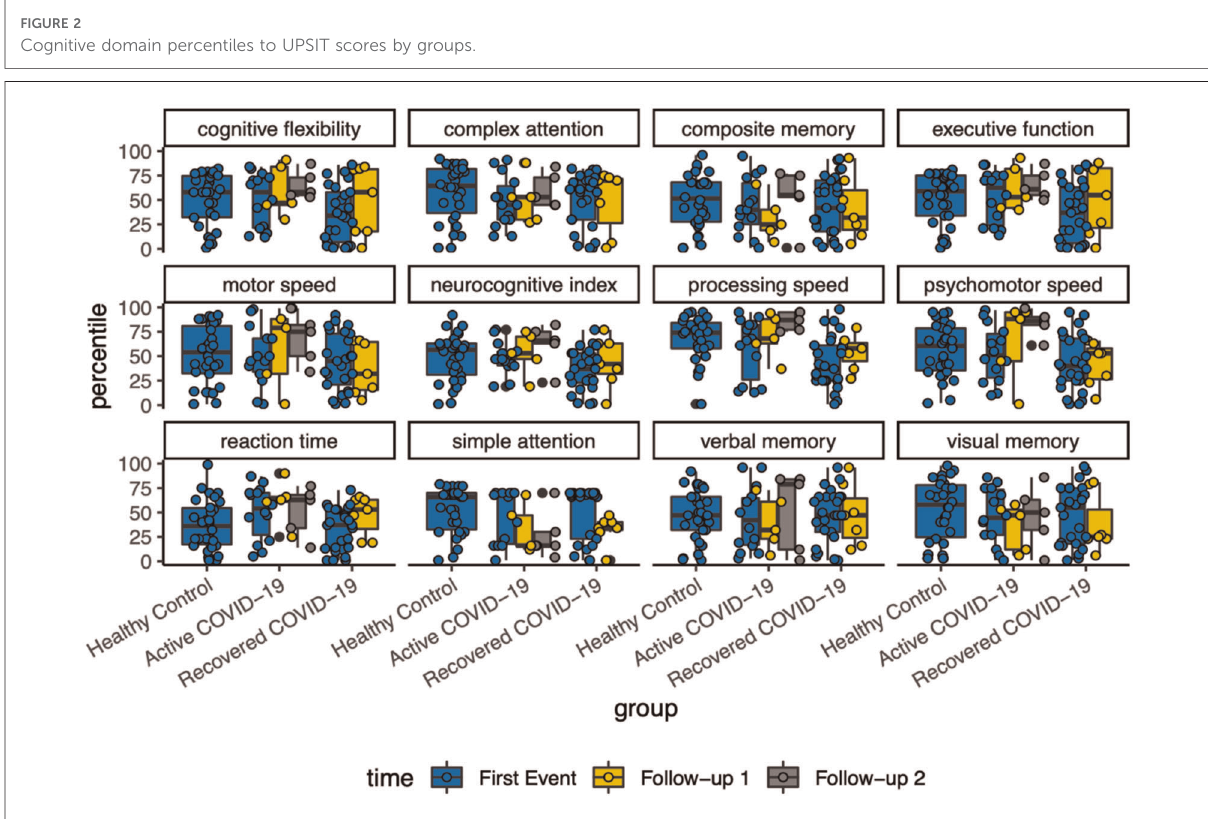
FIGURE 3 Cognitive percentiles over the course of follow